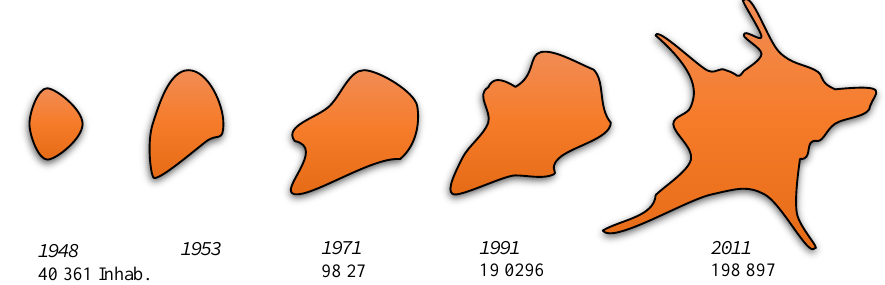
1948 40 361 Fig. 1. Spatial changes of land morphology through decades, city of Prishtina.